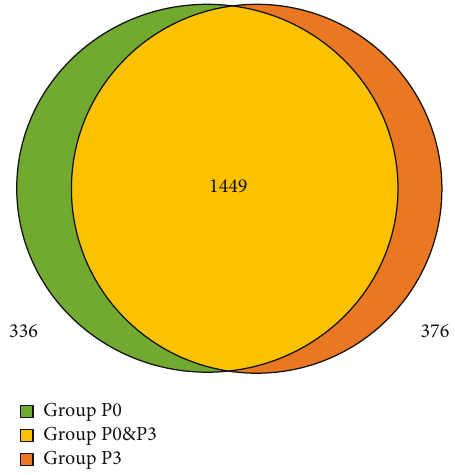
Figure 2: Venn diagram of proteins detected on LC-MS/MS. There were 1785 types of proteins identi fi ed from the mouse primary cultured cell (P0) sample and 1825 types of proteins identi fi ed from samples of cells passaged 3 times (P3). Among the 1785 types of proteins in mouse P0 cells, there were 336 types of proteins unique to the primary cultured cells (group P0). A total of 1449 types of proteins in mouse P0 cells were also identi fi ed in mouse P3 cells (group P0&P3). Among the 1825 types of proteins in mouse P3 cells, there were 376 types of proteins unique to the cells passaged 3 times (group